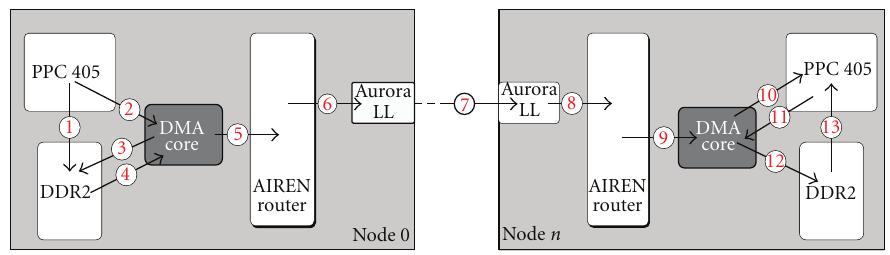
Figure 8: Example data flow of an AIREN hardware base MPI Send / MPI Recv